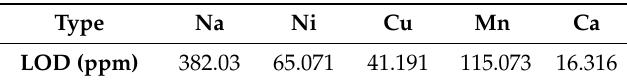
Table 3. LOD values for measured